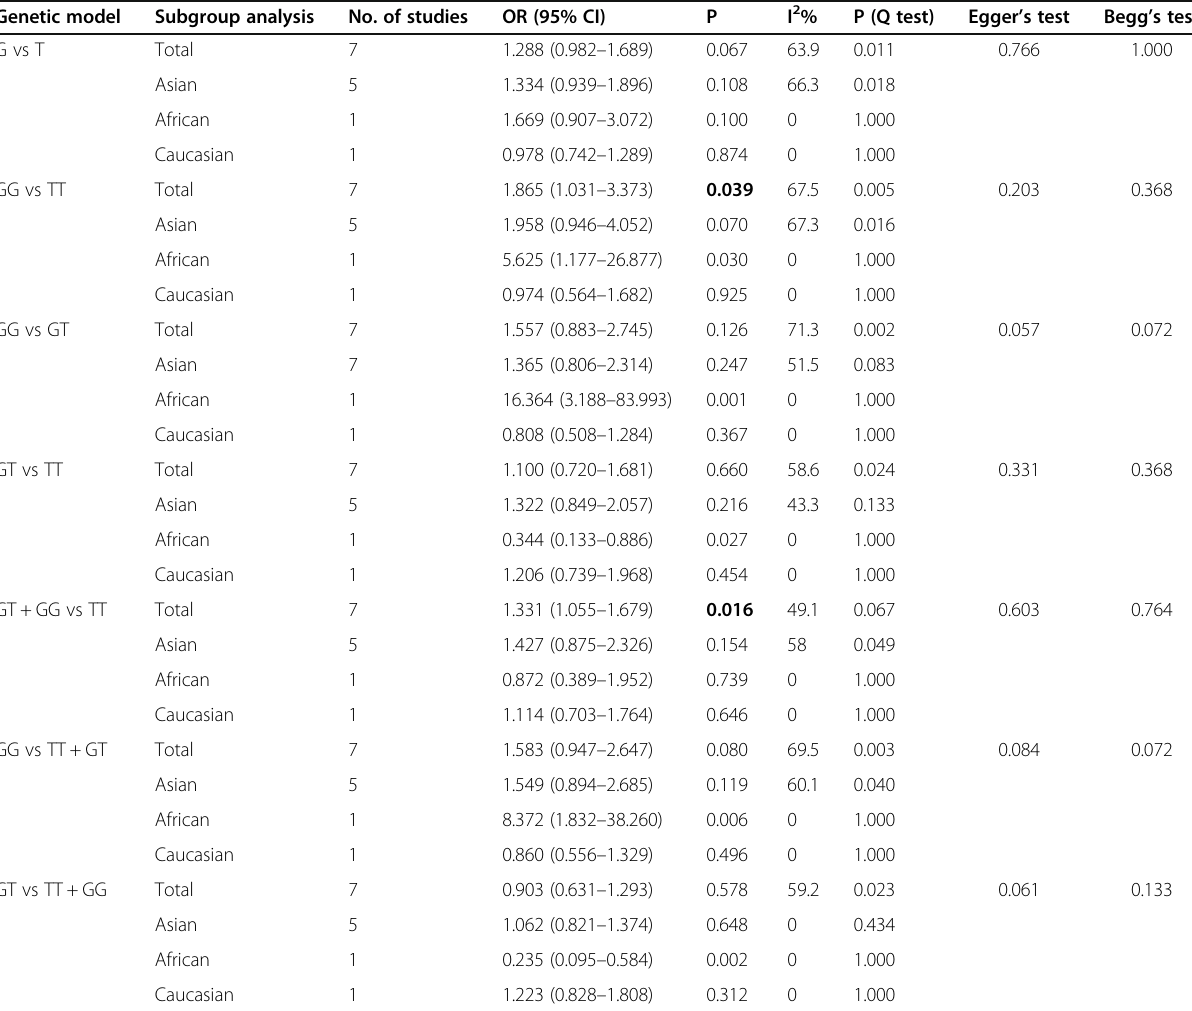
Table 2 Summary ORs (95% CI) of UGT1A1 (c.-3279 T > G) gene polymorphisms and neonatal hyperbilirubinemia risk Genetic